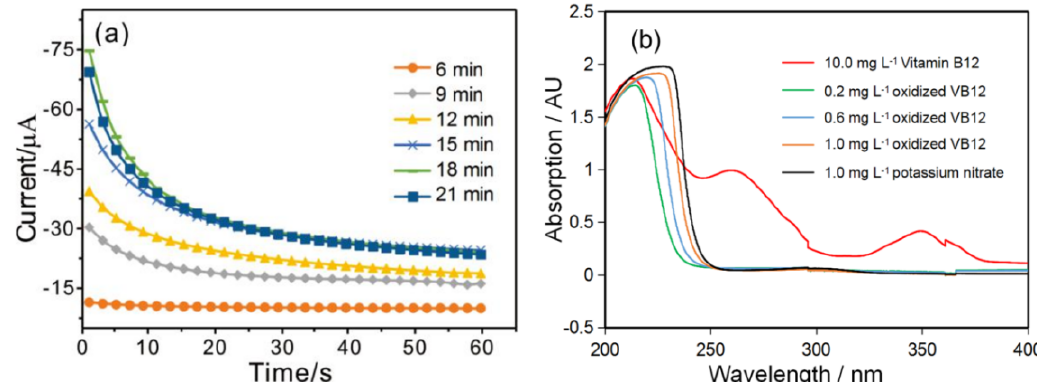
Figure 4. Effects of time on ( a ) current values; ( b ) absorption spectra of VB12, oxidized VB12, and potassium nitrate.